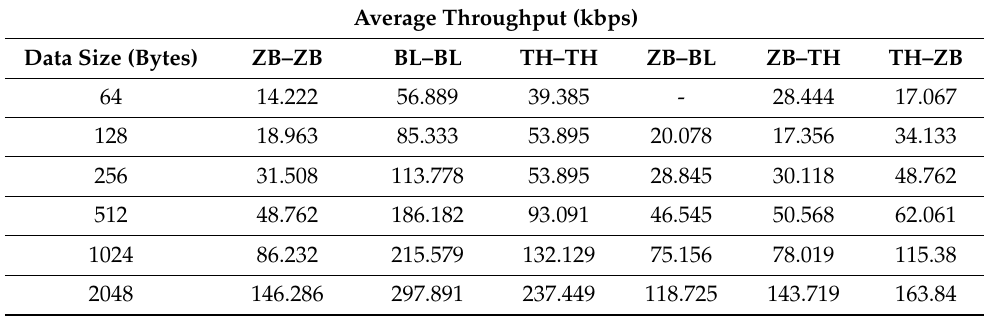
Table 5. Analysis of Average Throughput Performances with their Corresponding Connection